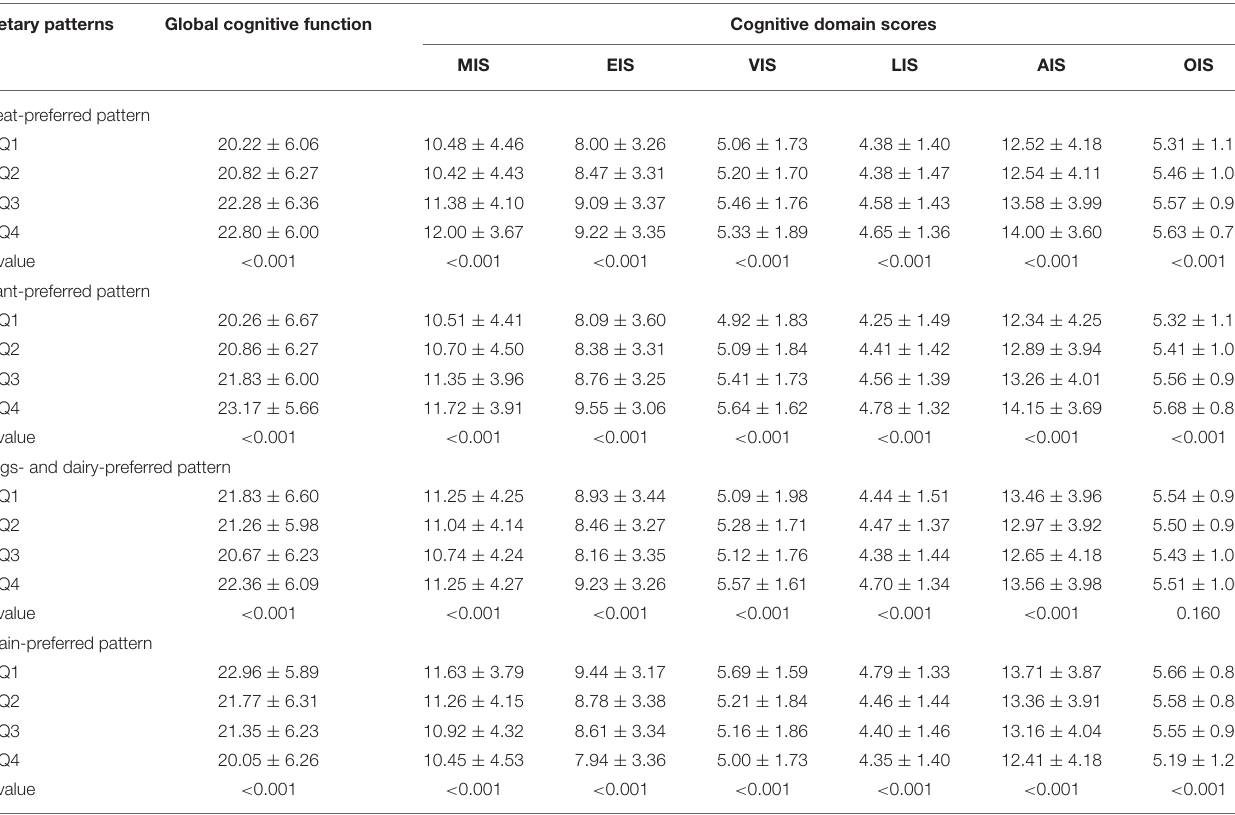
TABLE 3 | Differences in global cognitive score and cognitive domain subscores by quartiles of each dietary pattern score a . Dietary